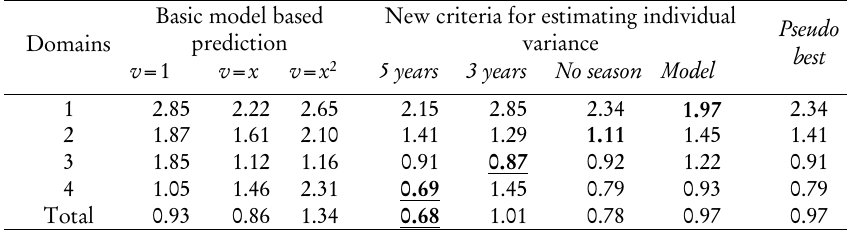
Comparison among MAPEs obtained through the use of the GREG estimator and different